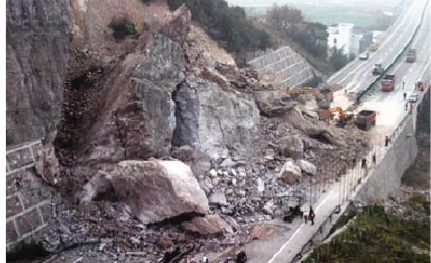
Figure 1: Collapsed highway